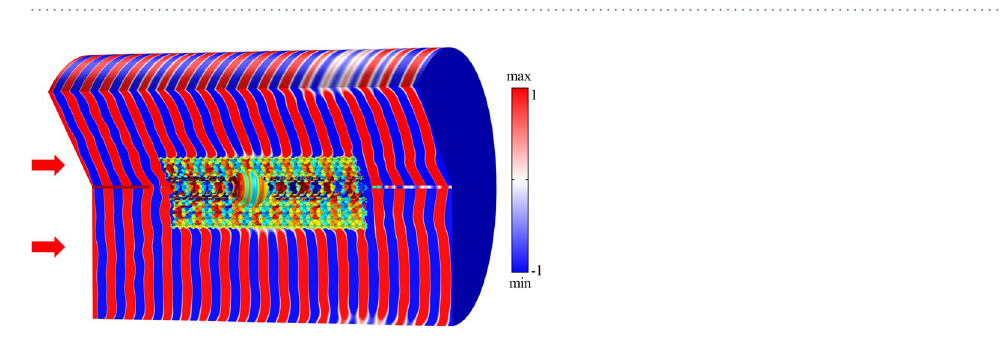
Figure 7. The simulated wave field of the cloaking device with a phase matching by introducing a phase delay device of length l 0 at 25 kHz.